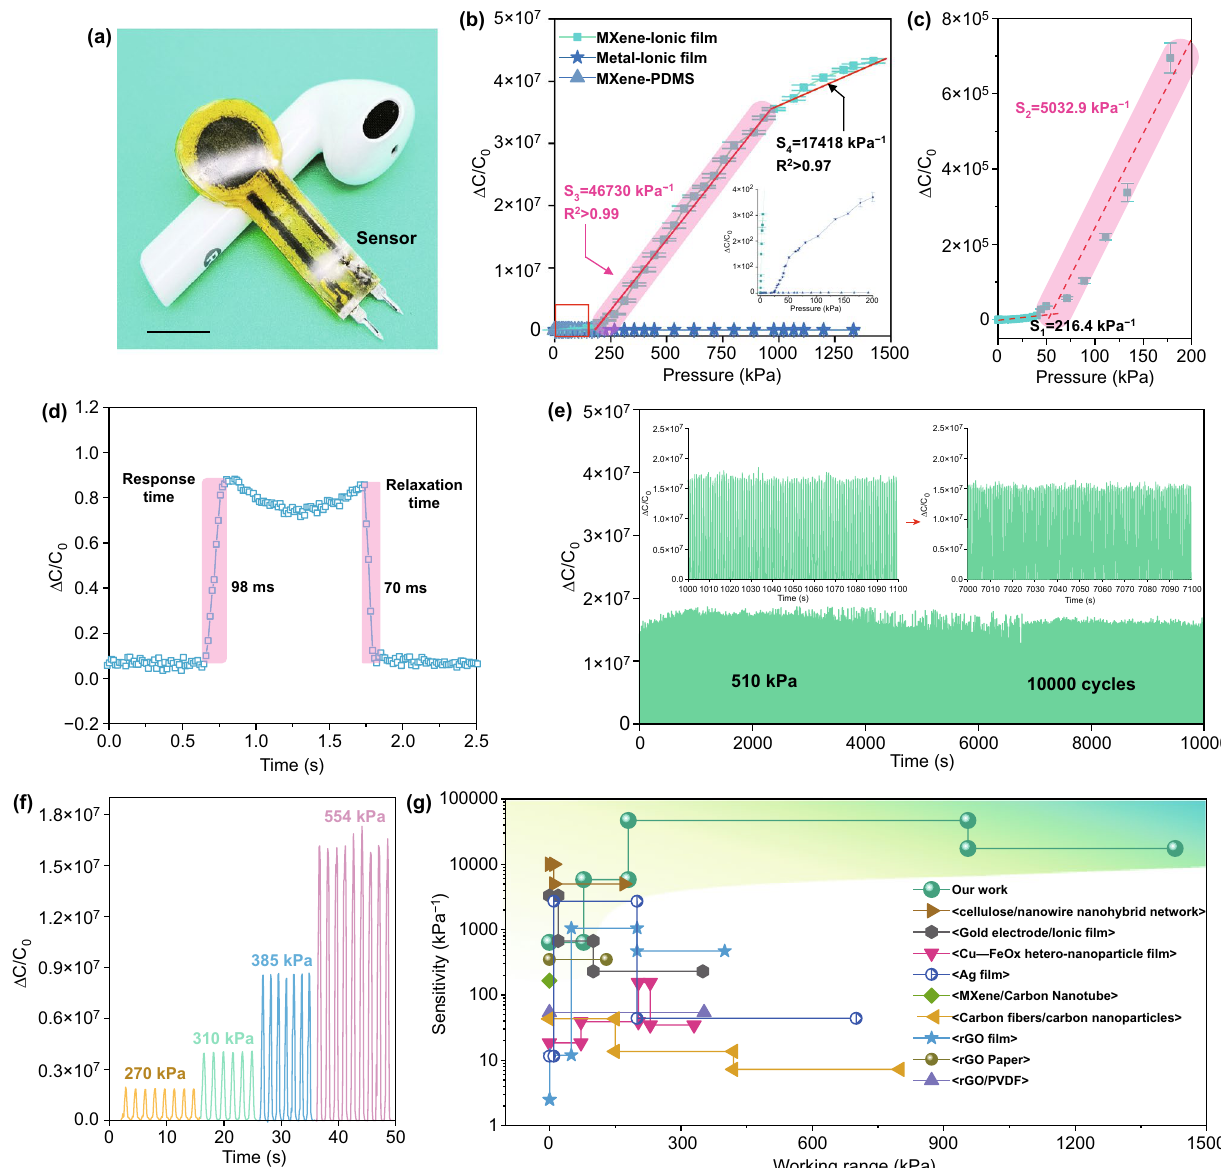
Fig. 3 Characterization of the sensor. a Digital optical image of the single sensor device. b Capacitance variation versus the pressure change of the sensing materials and c its corresponding large view. d Response and relaxation time of the flexible sensor. e Long-time durability of the sen- sor under 510 kPa. f Capacitance variation of the sensor under various pressure. g Comparison of our sensor’s sensitivity and sensing range with other reported